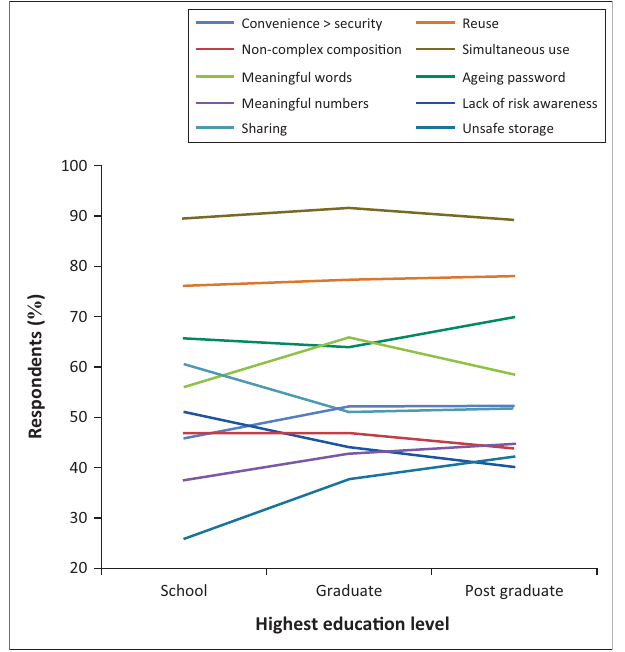
FIGURE 6: Weak password practices per highest level of education.